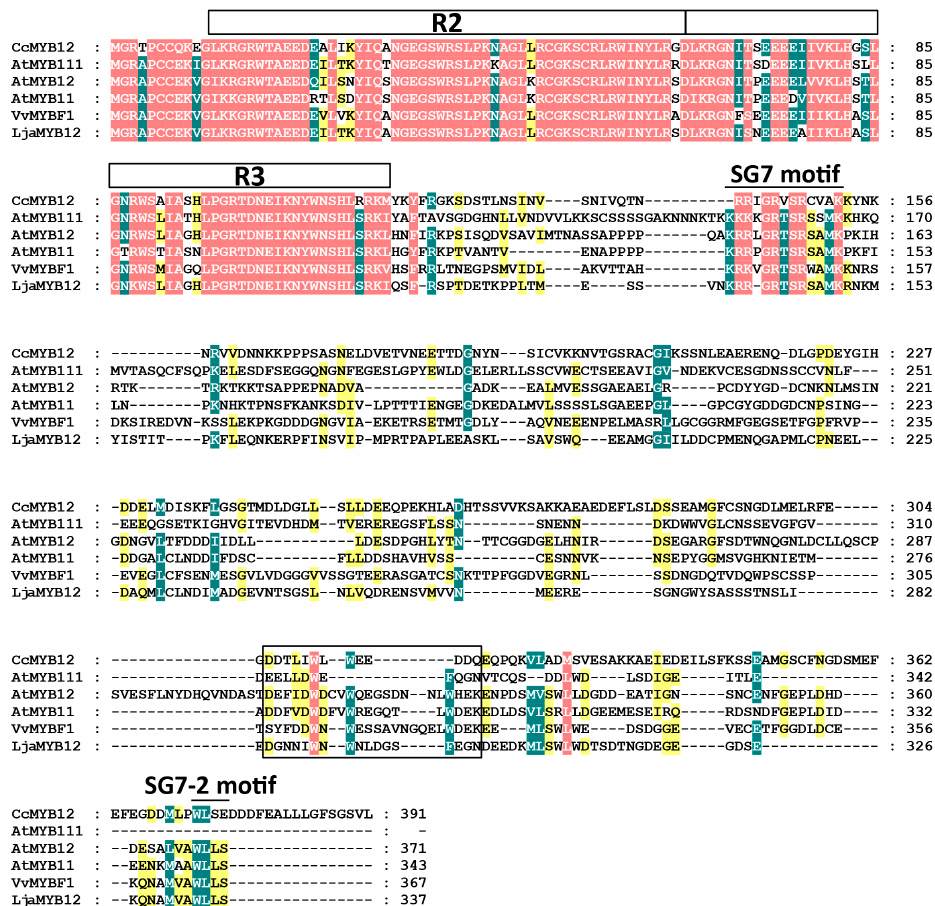
Figure 1. Multiple sequence alignment of LjaMYB12 and other subgroup 7 R2R3-MYBs. The position of the R2R3-MYB domain, SG7 motif and SG7-2 motif is indicated above the alignment and the predicted activation domain is highlighted by black box. Red, green, and yellow shades indicate sequence conserved percentage of 100%, 80%, and 60%, respectively. Proteins used for alignment are AtMYB11, AtMYB12 and AtMYB111 from A. thaliana , VvMYBF1 (ACT88298.1) from Vitis vinifera , CcMYB12 (AXF92691.1) from C. cardunculus var. scolymus , and LjaMYB12 from L. japonica . 2.2. The Transcriptional Level of LjaMYB12 Is Proportional to the Total Flavonoid Content during